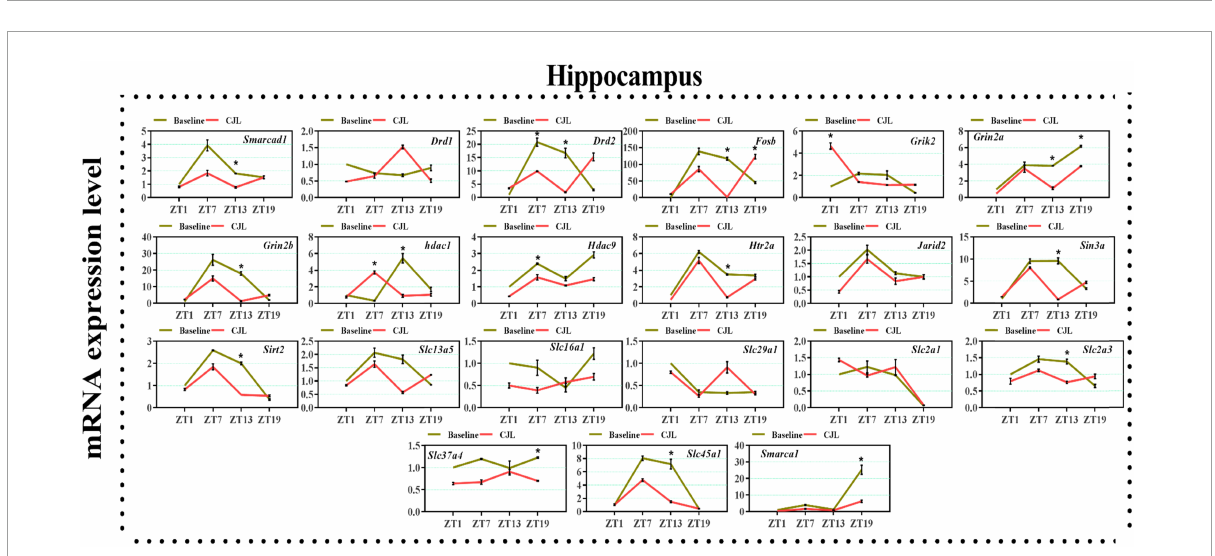
FIGURE4 Chronic jetlag (CJL) altered mRNA levels of genes associated with psychiatric disorders in the hippocampus. This figure shows mRNA levels in hippocampus extracts from baseline and CJL treated animals ( n = 3 per group), as assayed by three independent qPCR assays, at four different time points (ZT1, ZT7, ZT13, and ZT19). Results are expressed as mean ± SEM. * P < 0.01, two-way